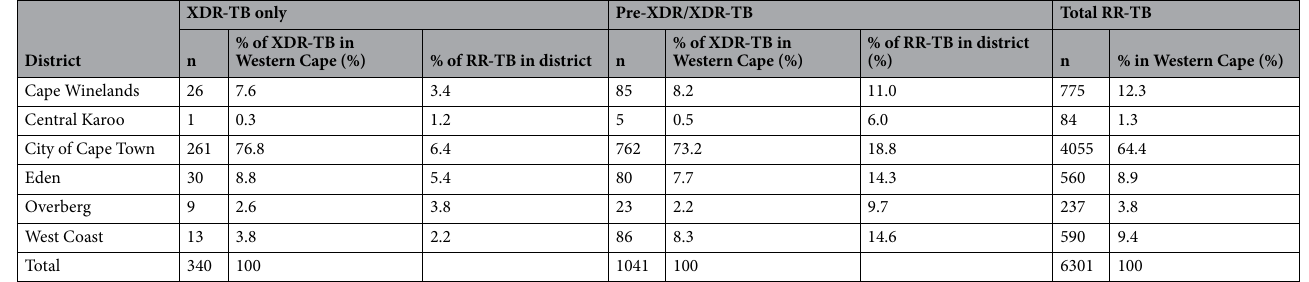
Table 2. Number and percentage of individuals with RR-TB, XDR-TB, and pre-XDR/XDR-TB in the Western Cape districts. XDR-TB extensively drug-resistant tuberculosis, RR-TB rifampicin resistant